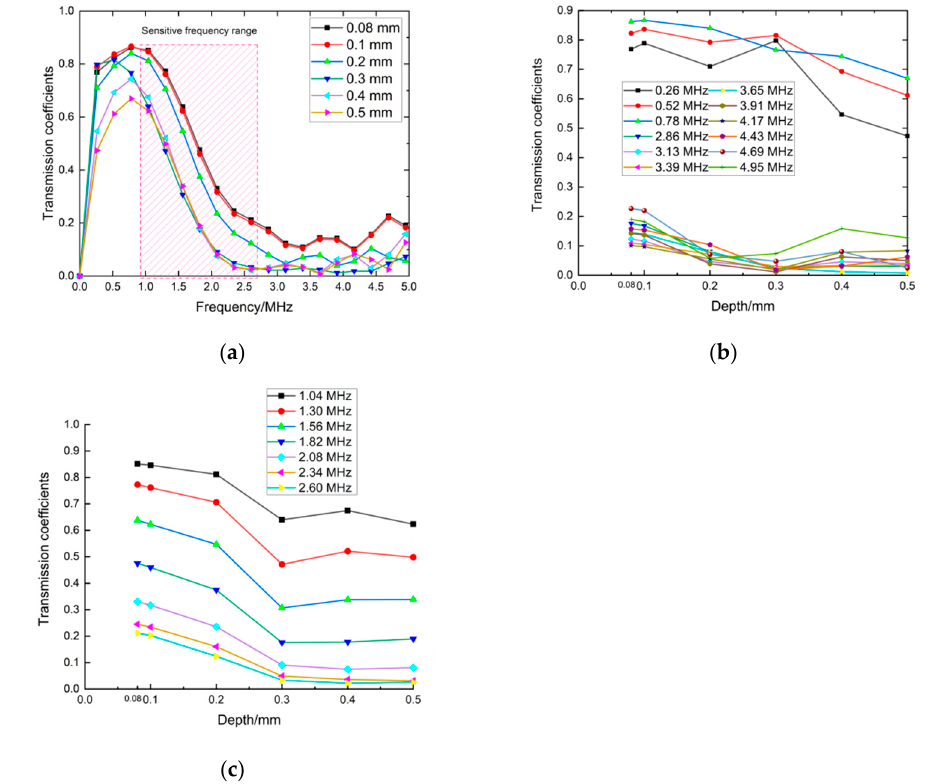
Figure 5. Transmission coefficients under different depths in the whole frequency range in ( a ), in the frequency ranging in 0.26 MHz ~ 0.78 MHz and 2.86 MHz ~ 4.95 MHz in ( b ) and in the frequency ranging in 1.04 MHz ~ 2.60 MHz in ( c ).